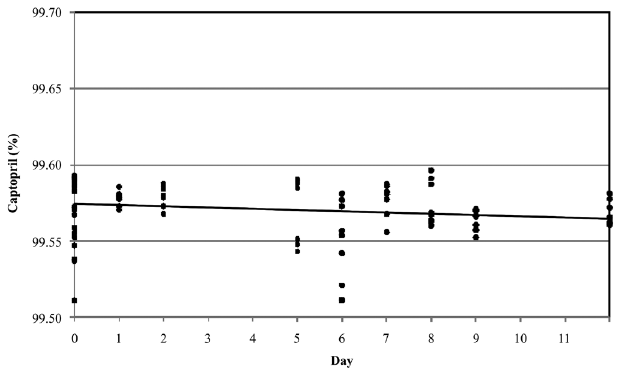
FIGURE 4 - Results for short-term stability study.